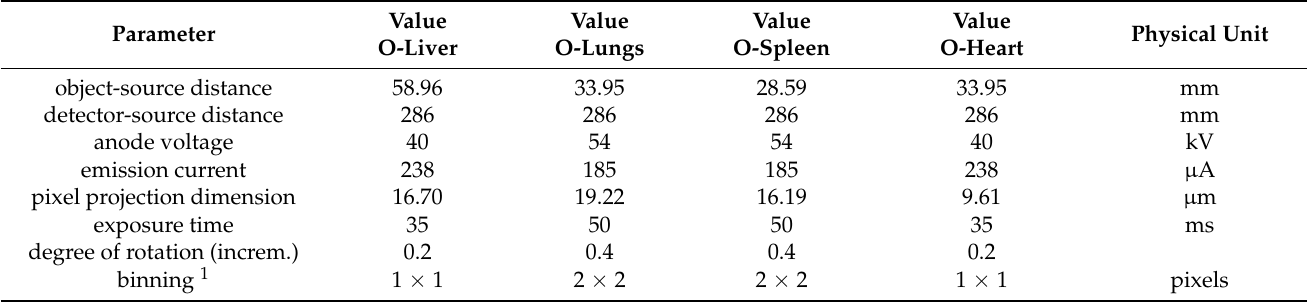
Table A18. Values of set parameters on SkyScan 1275.